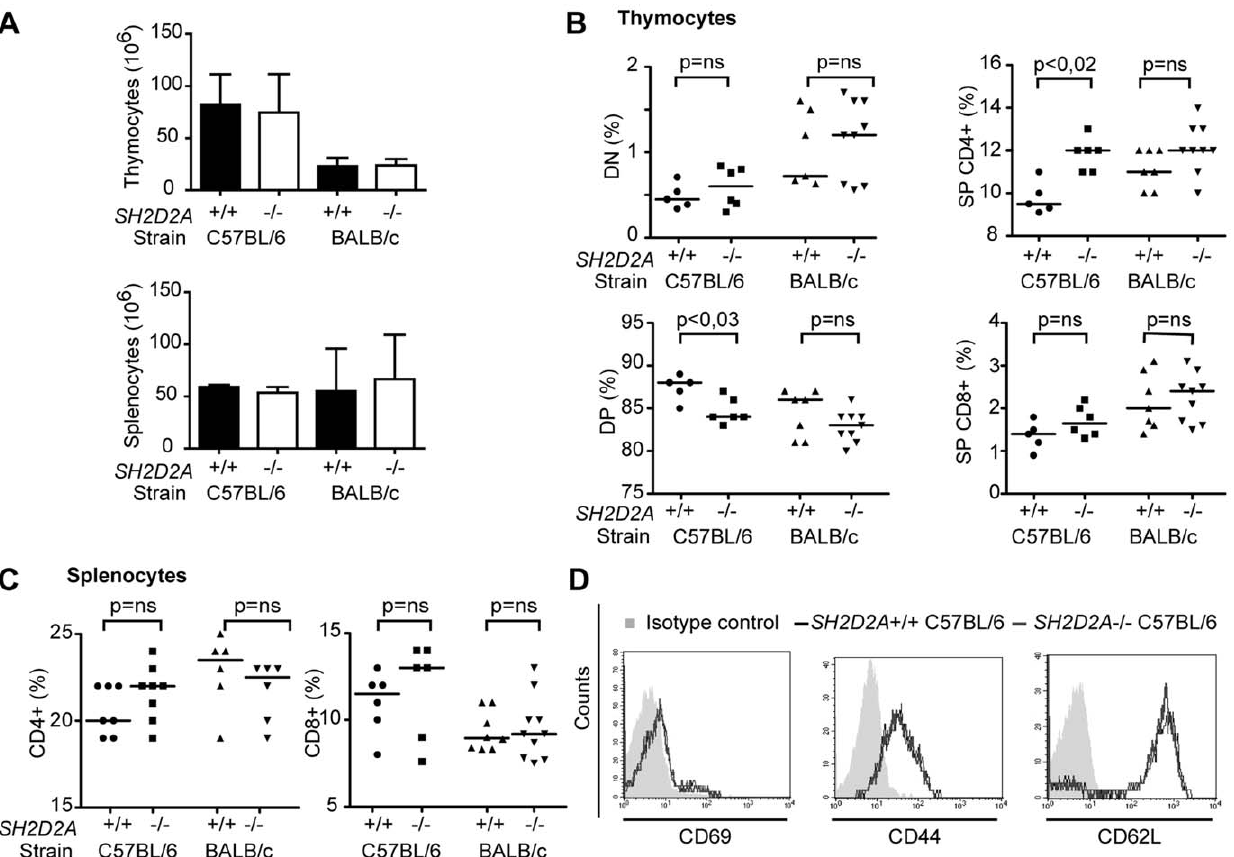
Figure 2. Small changes in thymocyte proportions in SH2D2A -deficient mice. (A) The graphs show the mean number of thymocytes (upper panel) and splenocytes (lower panel) with SD from SH2D2A -deficient C57BL/6 (7–16 weeks) and BALB/c (11–20 weeks) mice and corresponding age- matched controls. Student’s paired t-test showed no significant differences between the groups. (B, C) Thymocytes (B) and splenocytes (C) from C57BL/6 and BALB/c mice with indicated genotypes were labeled with anti-CD4 and -CD8 mAbs and their expression were monitored by flow cytometry. (B) The percentage of double negative (DN – upper left), double positive (DP – lower left), single positive (SP) CD4 + (upper right) and CD8 + (lower right) thymocytes is indicated for each genotype. (C) The percentage of CD4 + and CD8 + splenocytes is indicated in each group. (B, C) The median values are shown as lines in the diagrams P-values were calculated by the Mann-Whitney U test, p-values are indicated only when significant (p , 0.05). (D) Freshly isolated splenic CD4 + T cells were labeled with indicated mAbs prior to flow cytometry analysis. One representative experiment of at least four experiments performed on splenic CD4 + T cells from C57BL/6 mice (8–16 weeks old) is shown.